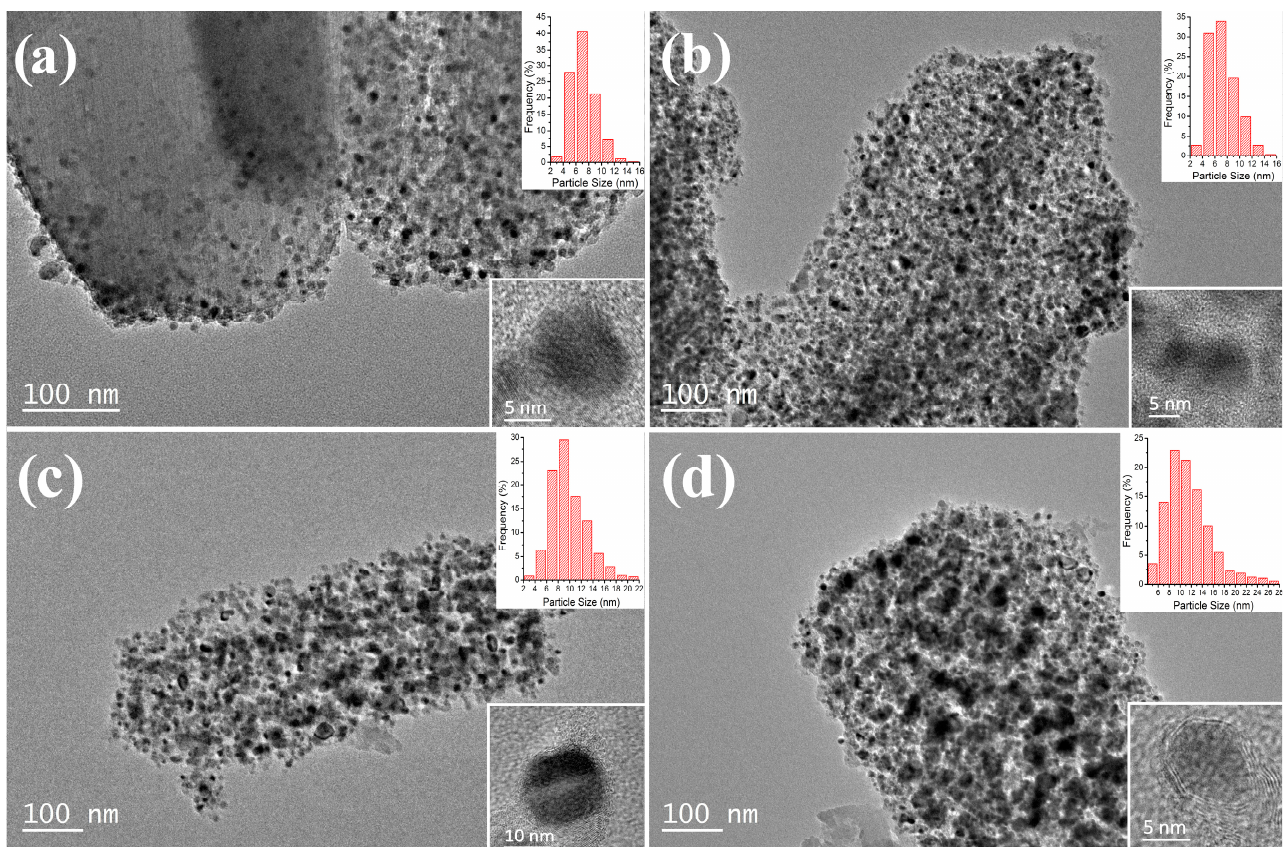
Figure 2. TEM images and corresponding particle size distribution of the Ni/C nanocatalysts with different treatment temperatures, ( a ) Ni/C-300, ( b ) Ni/C-400, ( c ) Ni/C-500, ( d ) Ni/C-600; inset is the magnified image of Ni 0 particle.